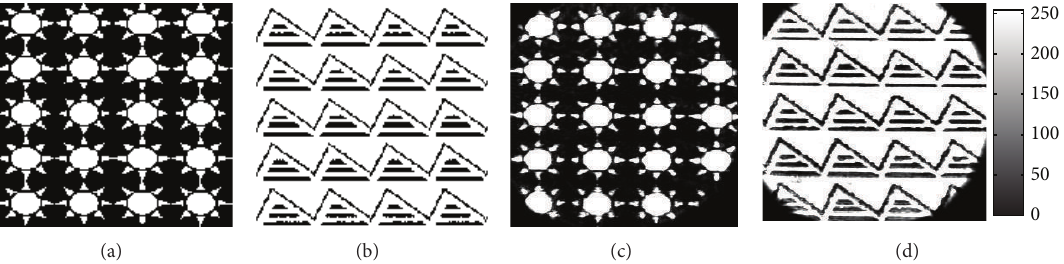
Figure 2: ((a) and (b)) Objects that were sent to the LCD using the BIM; ((c) and (d)) corresponding images of (a) and (b) obtained illuminating the SLM with the laser beam.